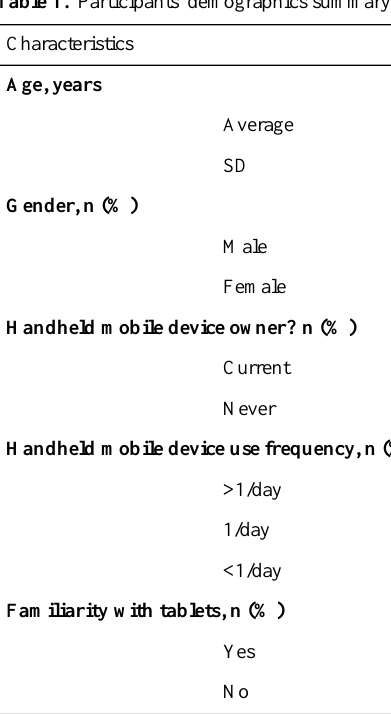
Table 1. Participants' demographics summary